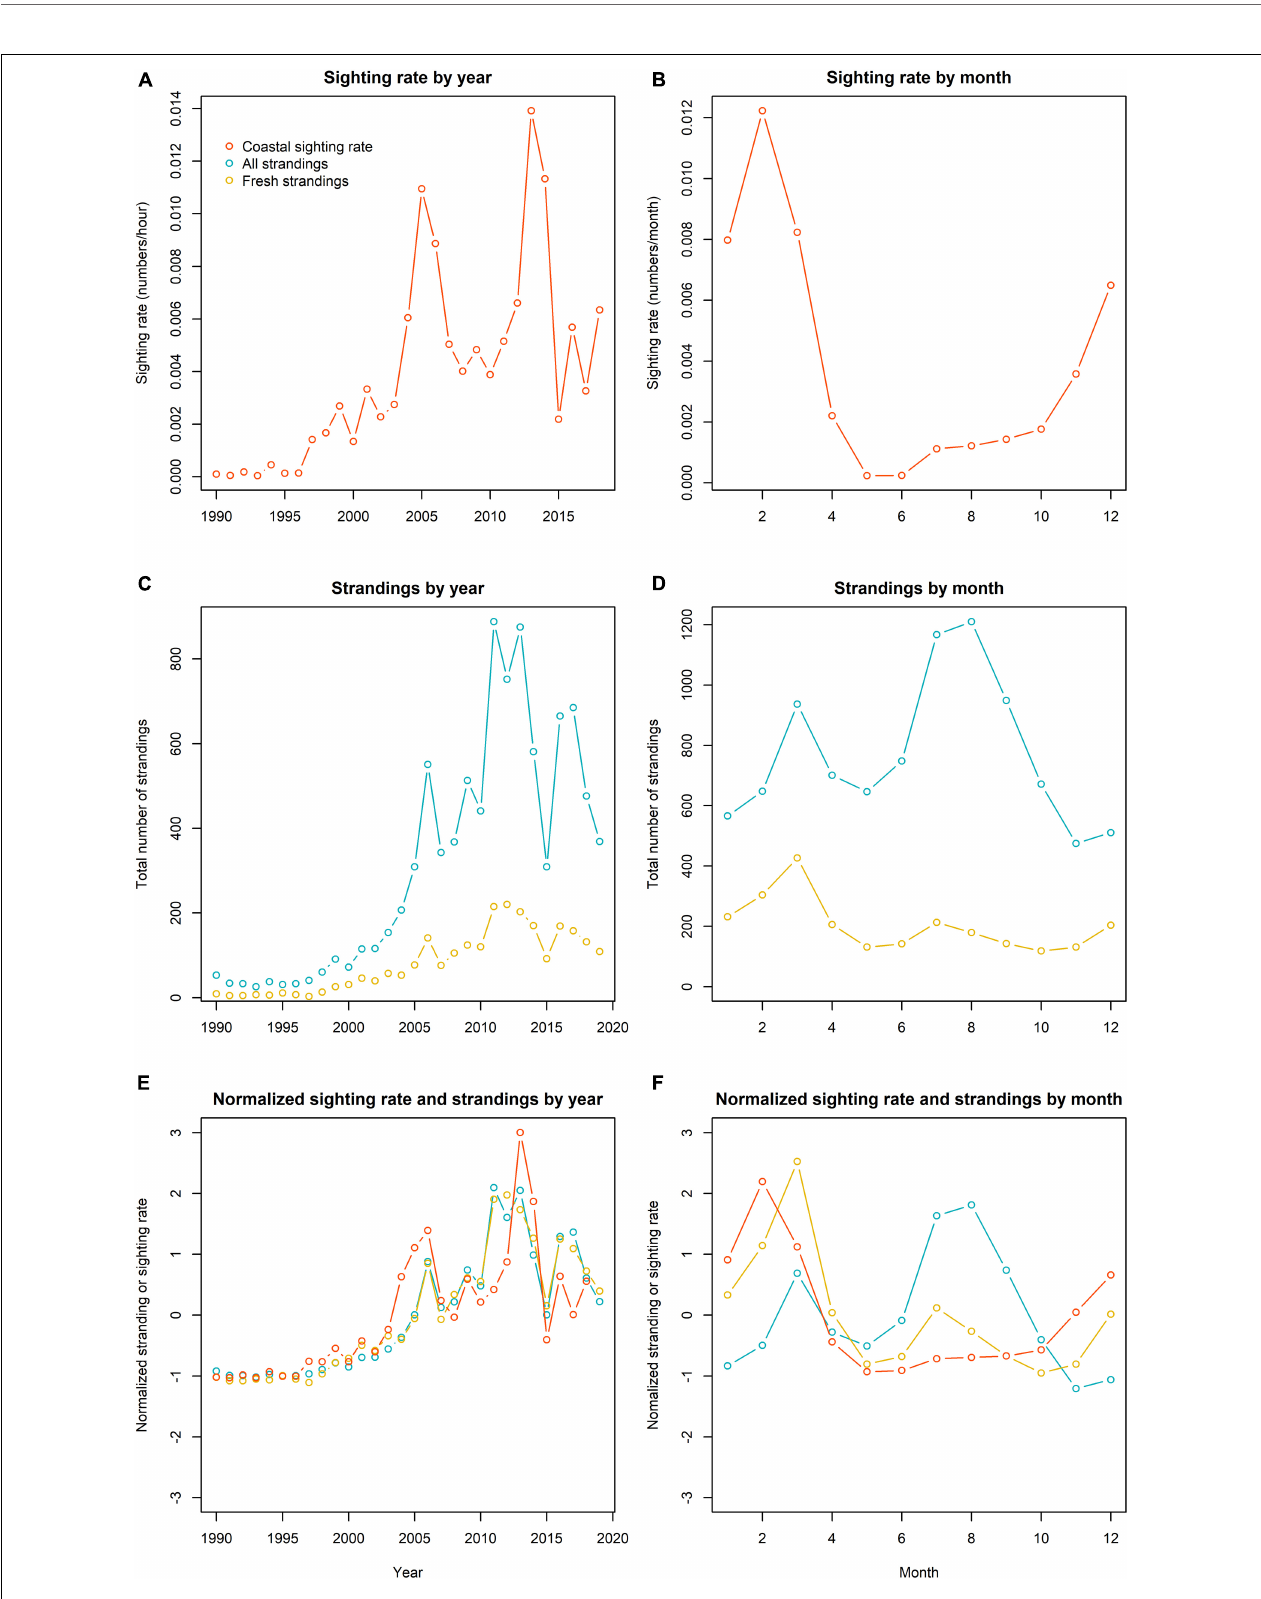
FIGURE 3 | Annual and monthly sightings and stranding patterns (orange = sightings, blue = all strandings, yellow = fresh and alive strandings). The lines reflect the variability in the sighting rate averaged by year (A) and month (B) , all strandings, and fresh and alive strandings by year (C) and month (D) and the normalized sightings and strandings by year (E) and month (F)